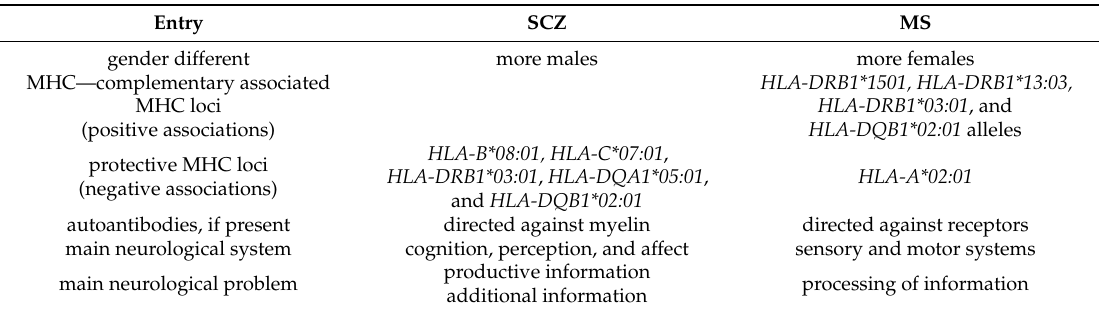
Table 1. The most important differences and similarities between MS and SCZ are summarized in this